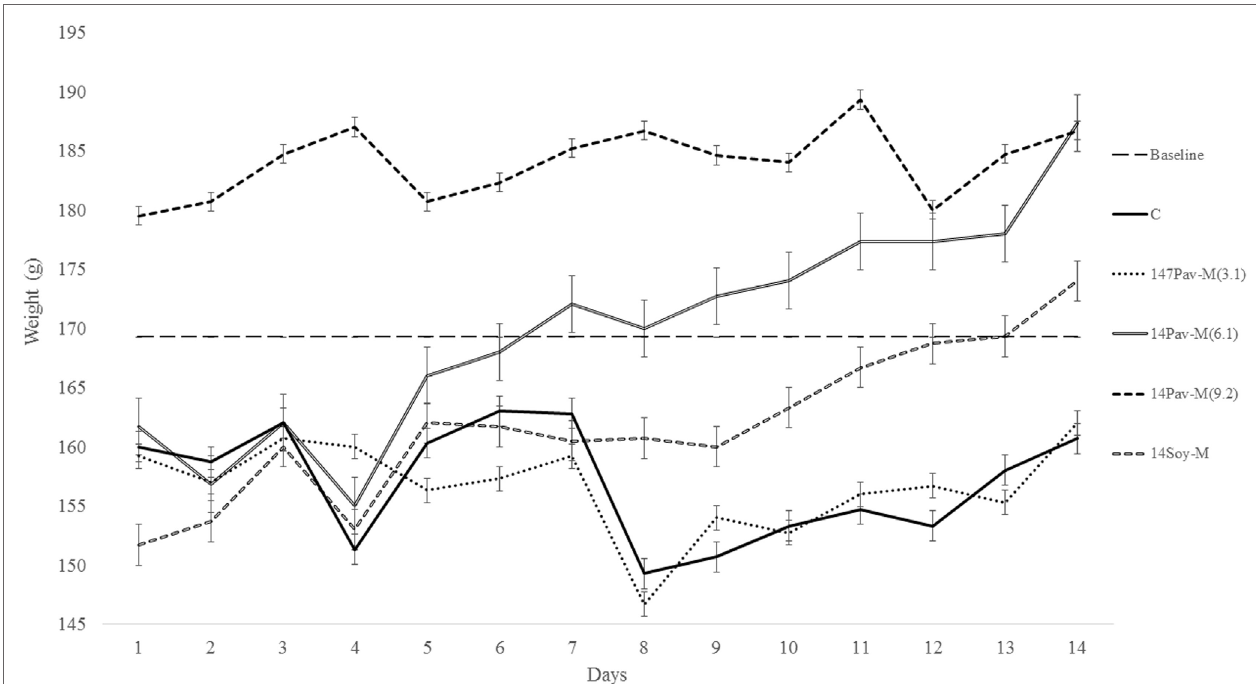
FigUre 3 | Changes in body weight during administration of different dosage of milk extracted from A. pavonina and soy bean. C, control; 14Pav-M(3.1), group with daily administration of 3.1 µl/g animal wt. pro-milk extract from A. pavonina seed; 14Pav-M(6.1), group with daily administration of 6.1 µl/g animal wt. pro-milk extract from A. pavonina seed; 14Pav-M(9.2), group with daily administration of 9.2 µl/g animal wt. pro-milk extract from A. pavonina seed; 14Soy-M, group with daily administration of 6.1 µl/g animal wt. pro-milk extract from soy bean